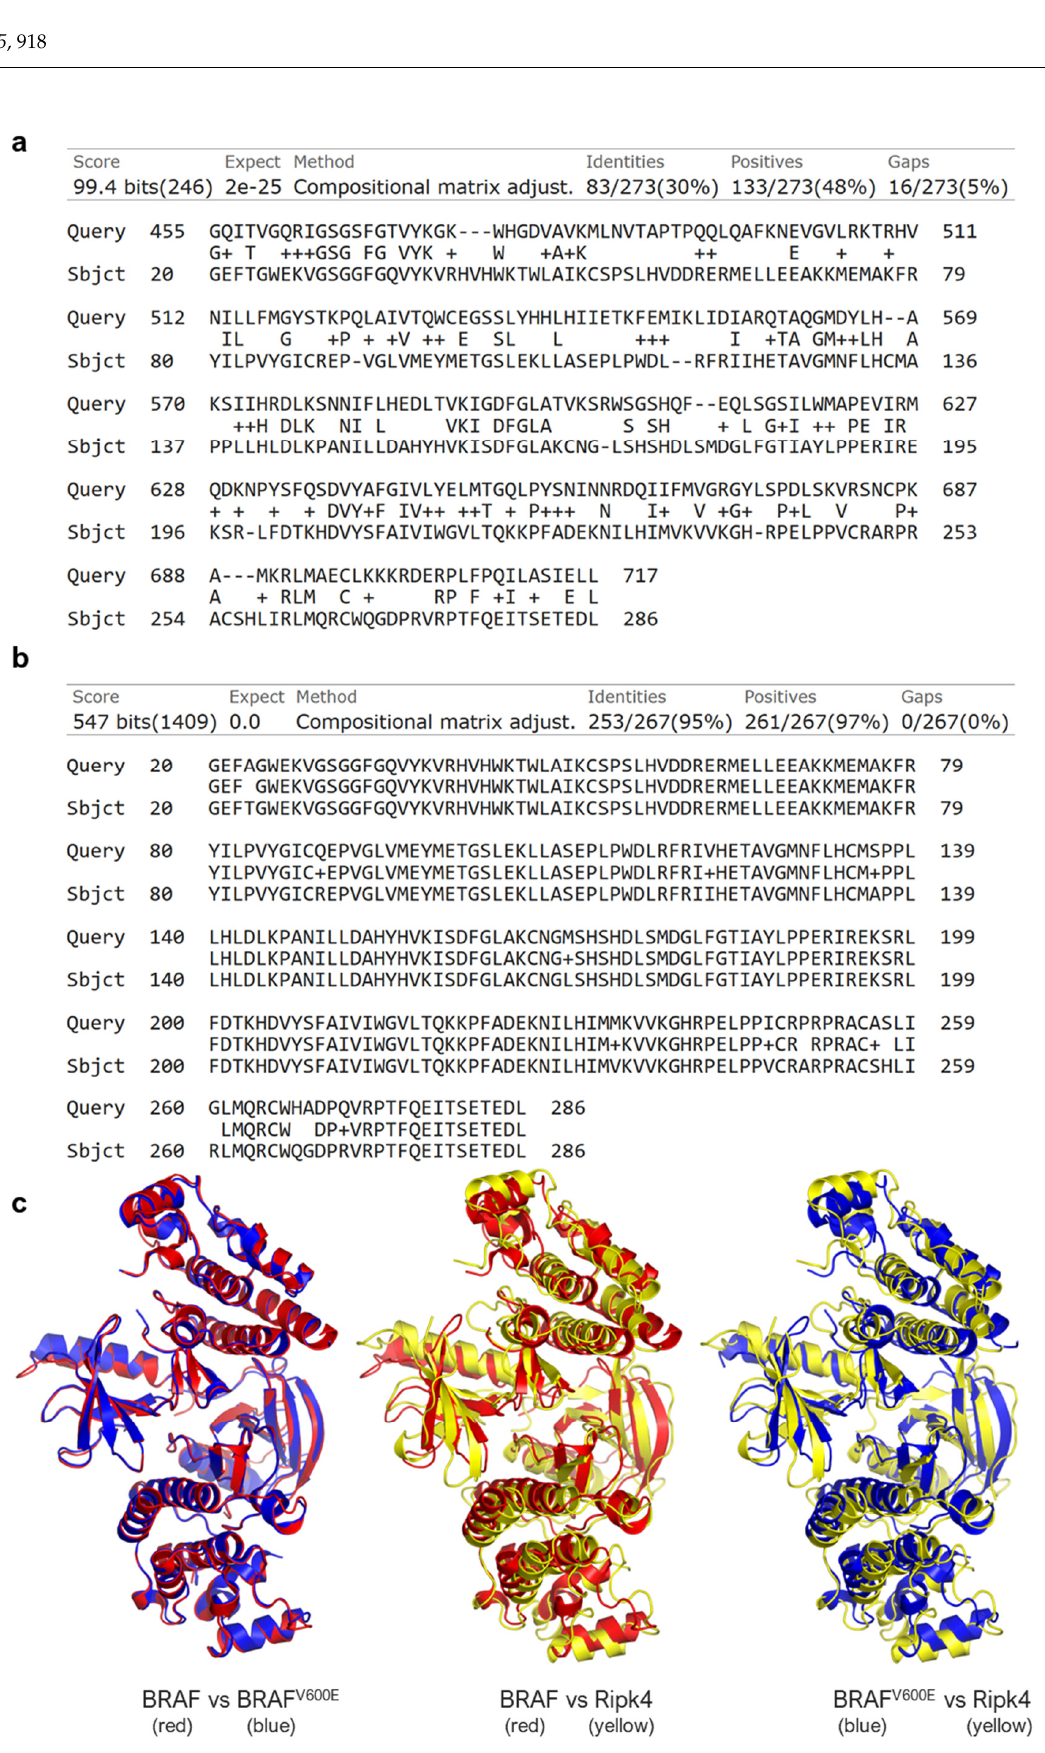
Figure 1. RIPK4 shows the sequence and structural similarity to the BRAF protein. ( a , b ) Comparison of amino acid sequences of human RIPK4 (Sbjct) with ( a ) BRAF (Query) or ( b ) mouse Ripk4 (Query) using BLAST. ( c ) Structural alignment of homodimers of human BRAF (red), human BRAF V600E (blue), and mouse RIPK4 (yellow) taken using PyMOL. The root mean square deviation (RMSD)